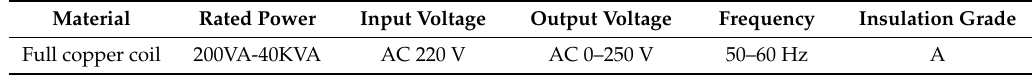
Table 2. Basic parameters of used voltage regulator.